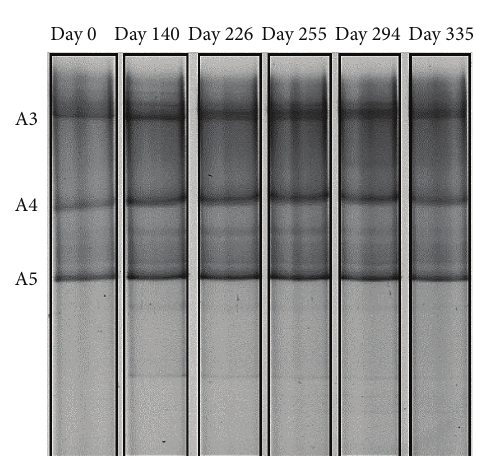
Figure 3: Denaturing gradient gel electrophoresis (DGGE) profiles of temporal archaeal 16S rRNA genes from EGSB